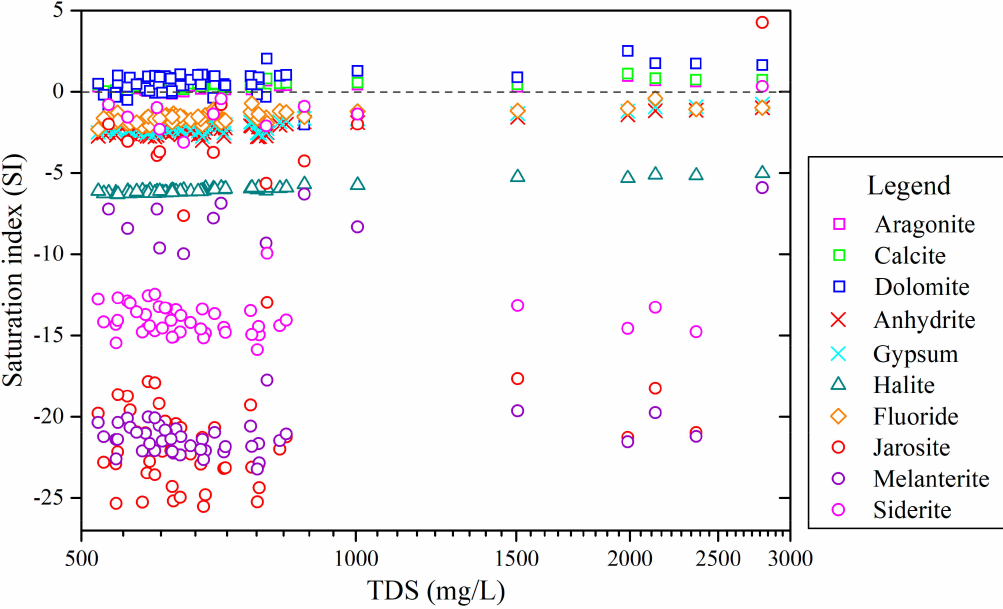
Figure 14. Saturation index of selected minerals in groundwater of the study